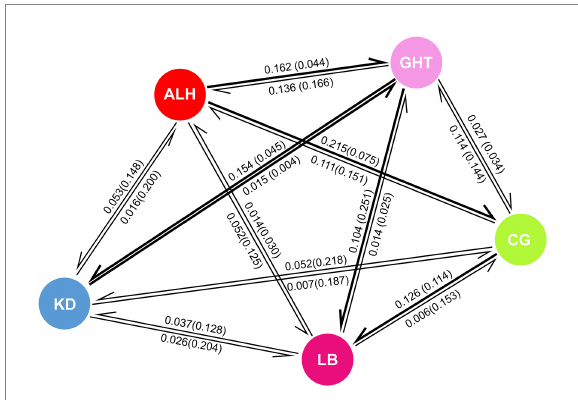
FIGURE 4 Comparison of historical and contemporary migration rates among five local populations. Numbers on arrows represent the proportion of migrated individuals in the original population, numbers in parentheses are historical values, and direction of arrows indicates direction of migration. Thick arrows indicate increases in contemporary migration compared to historical values, while thin arrows indicate decrease in contemporary migration.